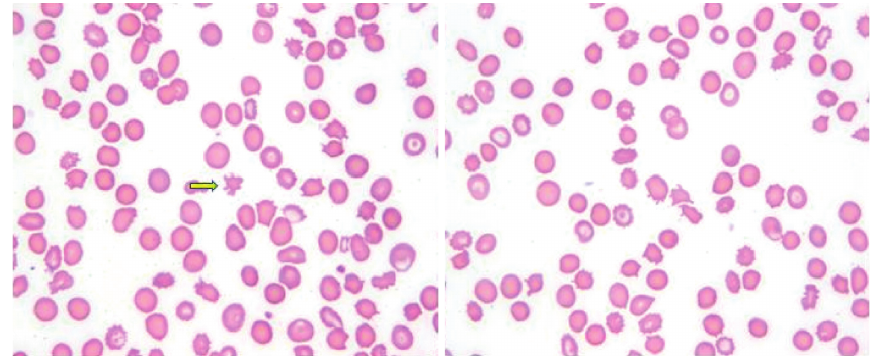
Figure 1: Peripheral smear using 100x objective lens demonstrating numerous acanthocytes (spur cells), spherocytes, target cells, and occasional burr cells. An example of a spur cell is identified with a yellow arrow. Table 2: Comparison of lipid panel before admission and during hospitalization.